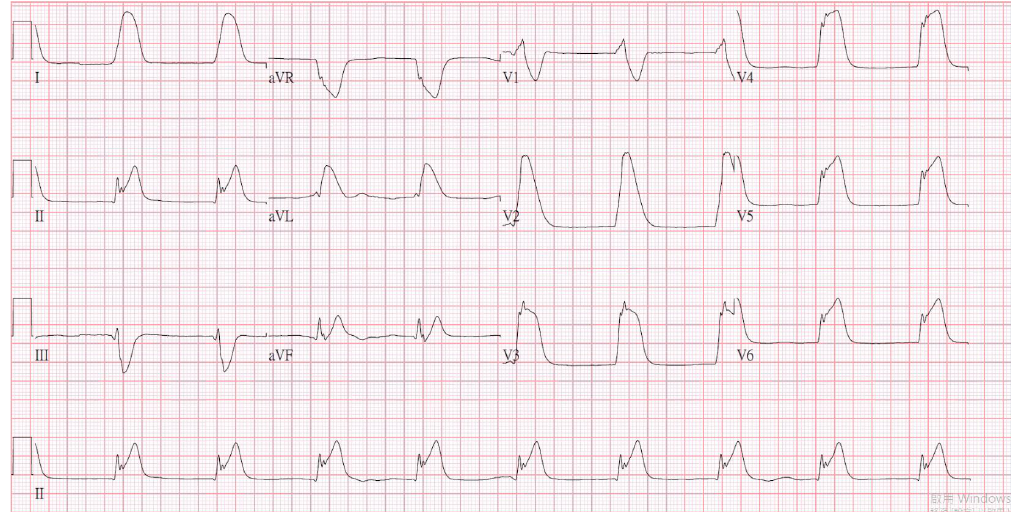
Figure 1. The initial electrocardiogram revealed ST-segment elevation in leads II and V 3-6 , and there was a spiked helmet sign.